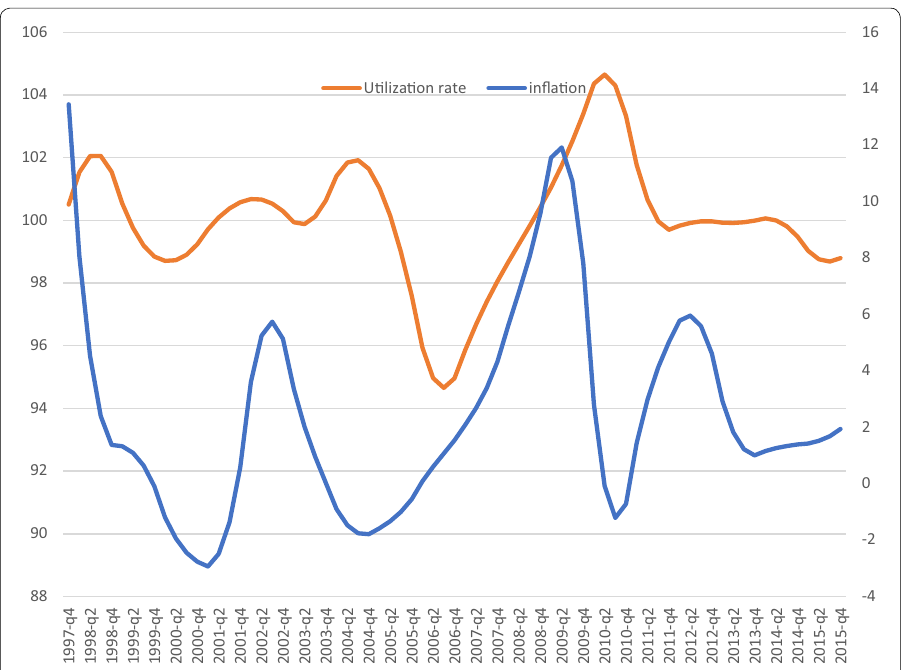
Fig. 4 Comparison between capacity utilization and inflation rates. Source : Author calculation based on data collected from